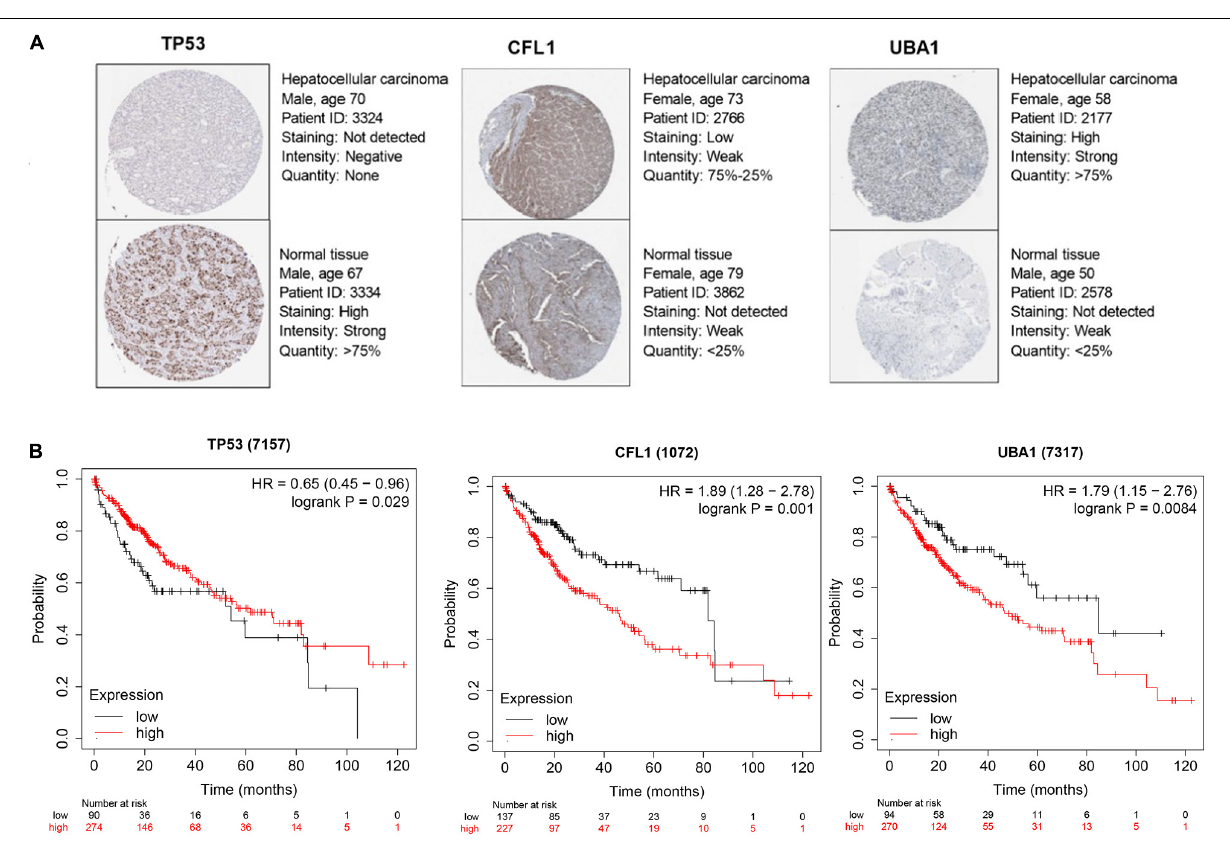
with its corresponding regression coefficient derived from the multivariate Cox regression model by the following formula: risk score = ( − 0.3946 × TP53 expression level) + (0.4447 × CFL1